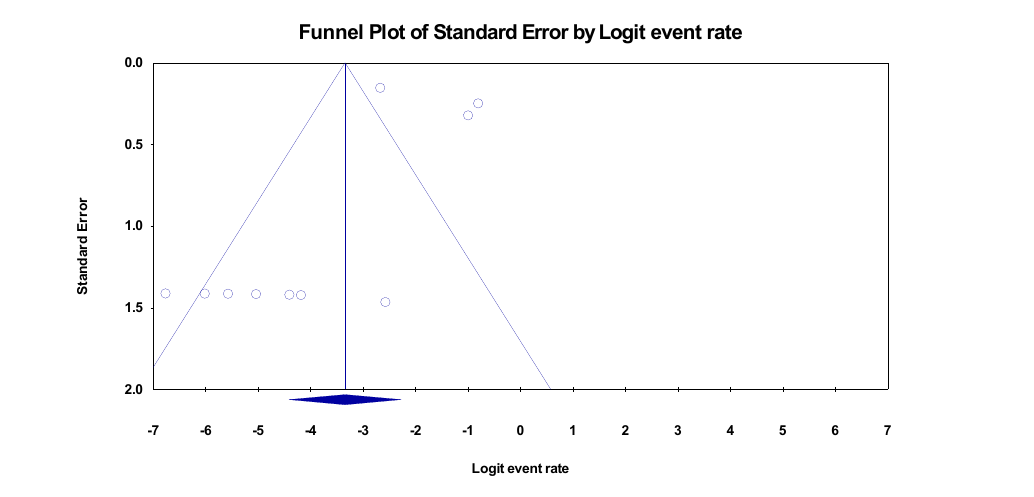
Figure 8. Funnel plot showing publication bias for SBP in HBC cirrhosis (Egger’s p = 0.24663).